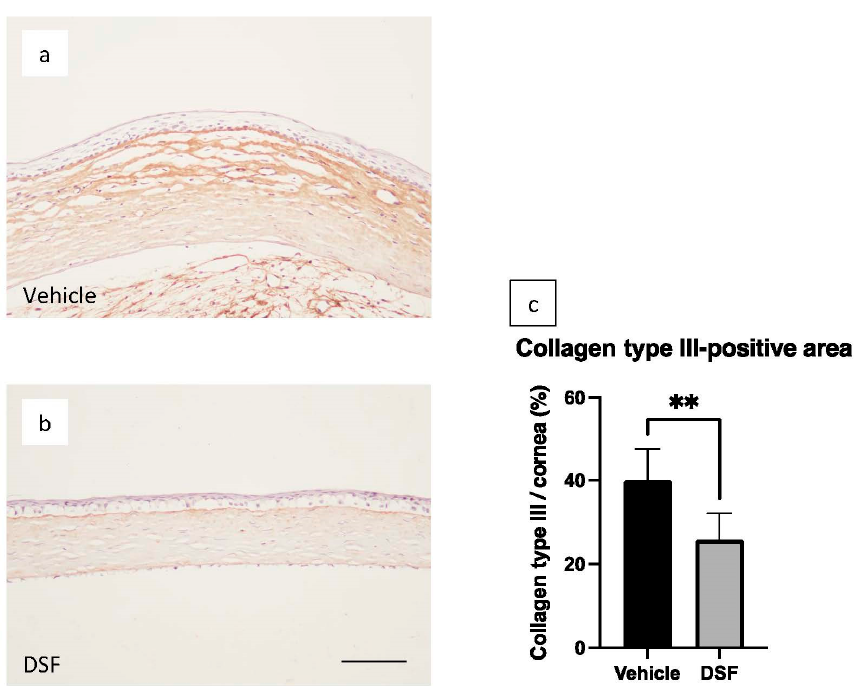
Figure 5. To evaluate central corneal scarring, immunohistochemical analysis of collagen type III in the Vehicle group ( a ) and DSF group ( b ) was performed in rat corneas 7 days after alkali burn. Comparison of the percentage of collagen type III expression area/corneal stroma area between the two groups showed a significantly lower percentage of collagen type III in the DSF group ( c ). Bar, 50 μ m. Data are shown as mean ± standard error ( n = 8 samples/group). ** p < 0.01.